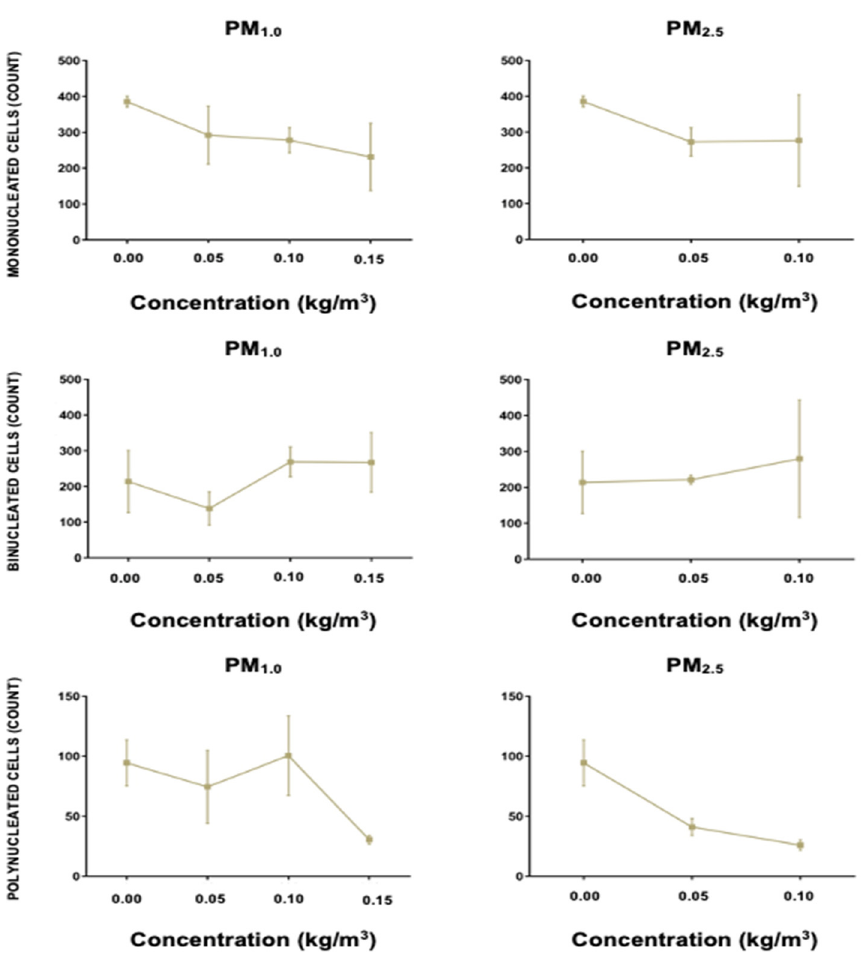
Figure 3. Cell count profile for both PM 1.0 and PM 2.5 .